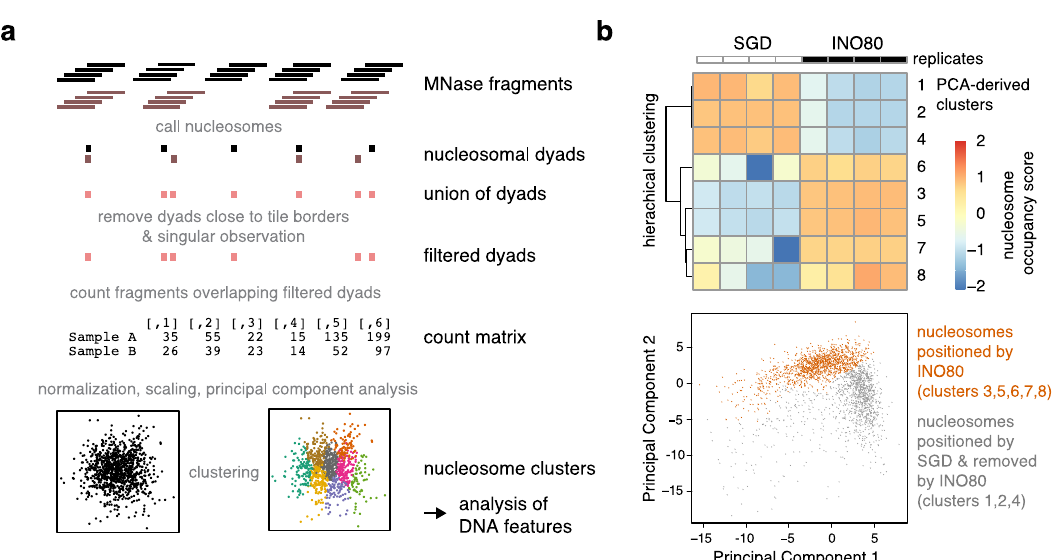
Fig. 3 Principal component analysis (PCA)/clustering approach. a Schematic of the analysis by using two conditions (black and gray) as an example. For details see main text and Methods section. b PCA/clustering approach applied to paired-end MNase-seq data of eight replicates of SGD chromatin prepared with embryonic D. melanogaster histones at histone-to-DNA mass ratio of 0.4 and either alone (SGD; n = 4) or after incubation with S. cerevisiae WT INO80 complex (INO80; n = 4). For paired-end sequencing datasets see Supplementary Data 2 and GEO deposition at GSE145093. In total, 2393 fi ltered nucleosome dyad positions were derived. Based on sequencing reads, nucleosome positions were subjected to a PCA from which eight clusters were derived by K-means clustering. Nucleosome occupancy scores were calculated for each replicate condition in a PCA-derived cluster. Based on these scores a row scaled heatmap (upper panel) was generated by red – white – blue color coding and hierarchically ordering in order to visualize the outcome of the PCA/clustering analysis. INO80 preferentially positioned nucleosomes at genomic positions identi fi ed in clusters 3, 5, 6, 7, and 8, which constitute together the group of nucleosomes positioned by INO80, while the respective positions were not frequently occupied in SGD chromatin. Conversely, clusters 1, 2, and 4 identi fi ed genomic positions that were frequently occupied by nucleosomes in SGD chromatin, but remodeled into different positions by INO80. The two groups of nucleosome positions are clearly distinct in a principal component 1 (PC1) versus PC2 plot as shown in the lower panel (gray: nucleosome of clusters 1, 2, and 4; orange: nucleosome of clusters 3, 5, 6, 7, and 8). Taken together, the analysis reveals that INO80 remodeling alters almost the entire landscape of respective nucleosome positions. DNA features of nucleosomes belonging to the two groups of clusters were further analyzed as presented in Fig.